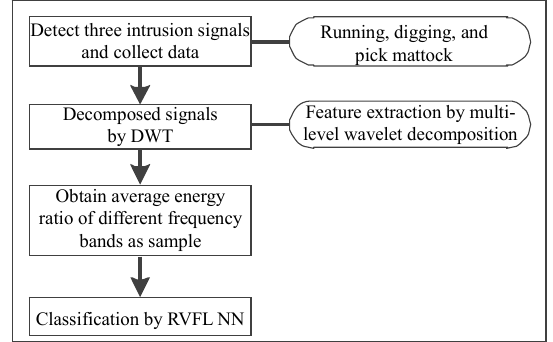
Fig. 1 Processing flow of intrusion signal recognition.